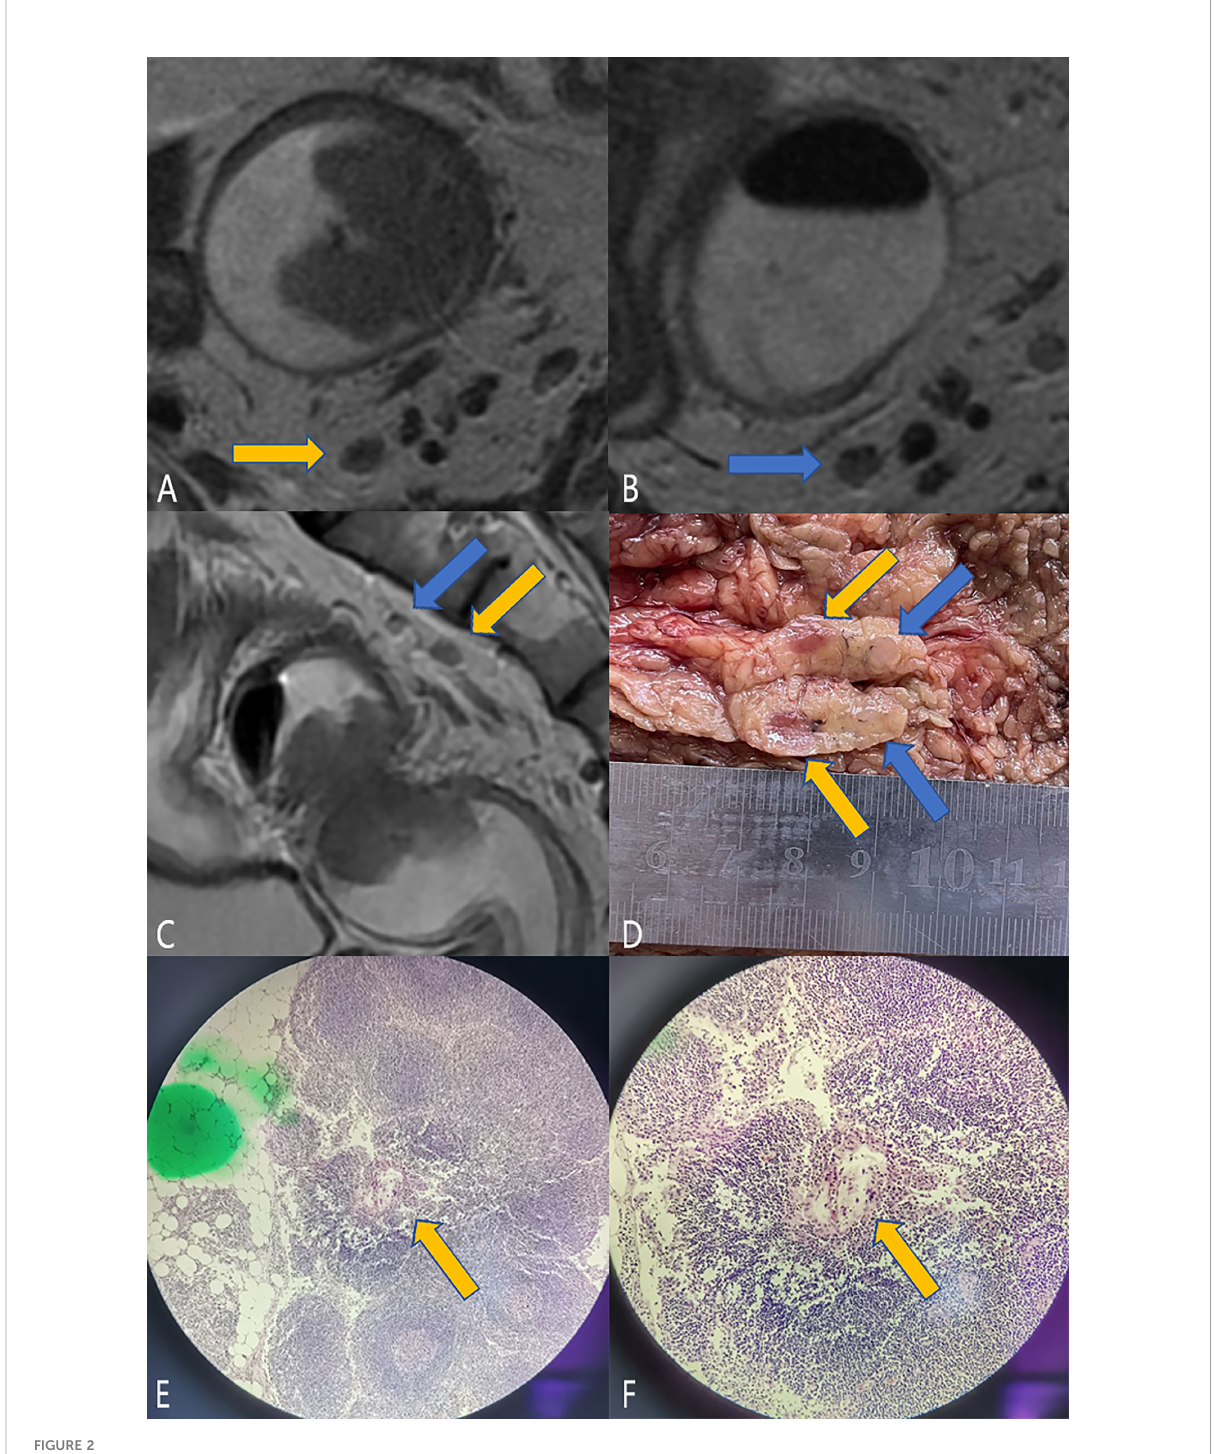
FIGURE 2 LN imaging – pathological localization process. Male, 59 years old, rectal cancer (t3n1, a regional metastatic LN, the lesion length on MR is 4.2 cm, and the pathological lesion size is 4 * 4 cm). (A – C) are the magnetic resonance images. Panels A and B show the two LNs (blue and orange arrows) in the upper mesentery in the oblique cross-sectional position, and panel (C) shows the positional relationship of the two LNs in the sagittal position (blue and orange arrows). It can be seen that the two LNs are adjacent up and down. Panel (D) shows the two LNs located on the resected specimen. For better display, the two LNs have been cut open. After section staining, metastasis was found in the LNs indicated by orange arrows, as shown in panels (E, F) . Then, the LN was successfully located and turned out to be a malignant LN. Combined with the fi nal pathology, there was only one LN metastasis, and the remaining LNs were considered as benign